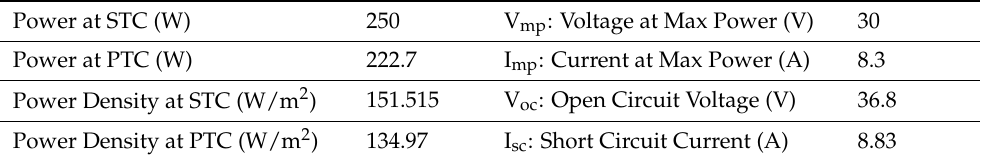
Table 1. TATA power solar system TP250MBZ module